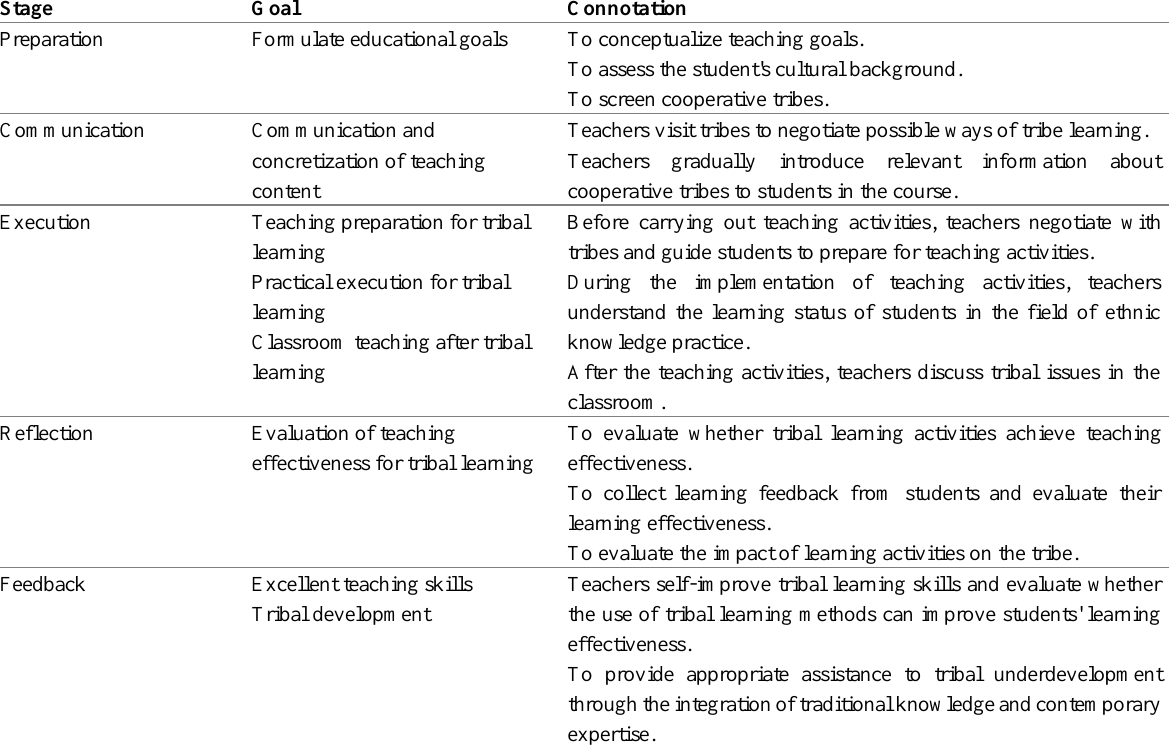
Table 1: Stages, Goals, and Connotations of the Tribal Learning Instructional